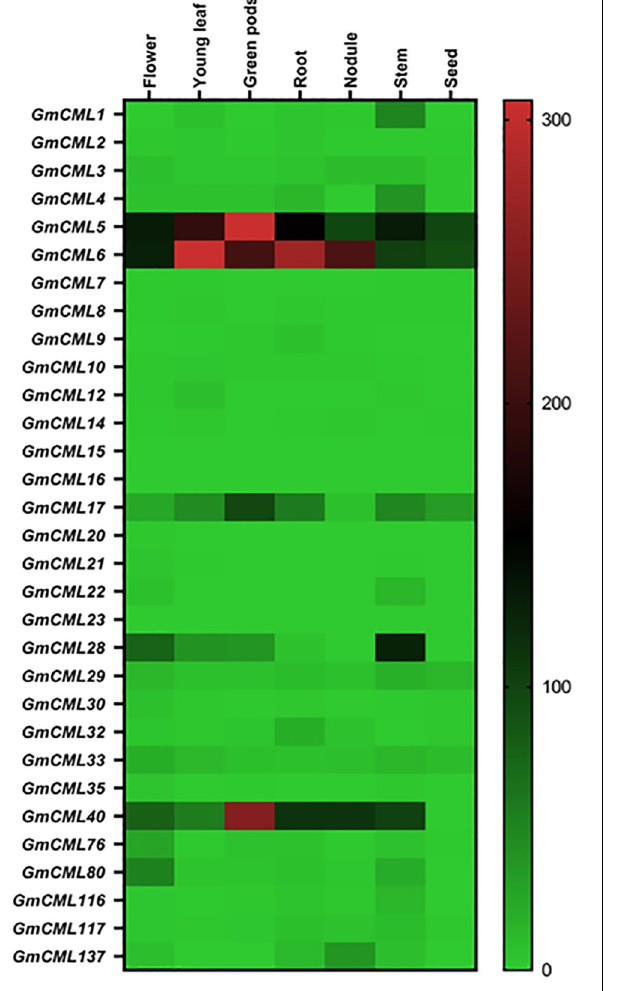
FIGURE 6 | The expression profile of GmCML s in different tissues of soybean. Heat map showing expression profiles of GmCMLs in different tissue types of G. max . The RPKM values were obtained from SoyBase Expression Explorer. The heat map has been generated using Graphpad Prism software.